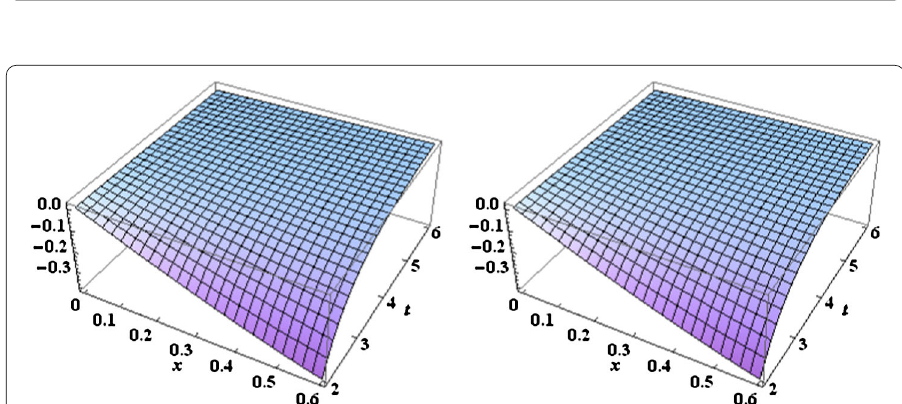
Figure 4 The exact and approximate solutions for Example 4.2, respectively, when η = 0, ν = 1, ε =